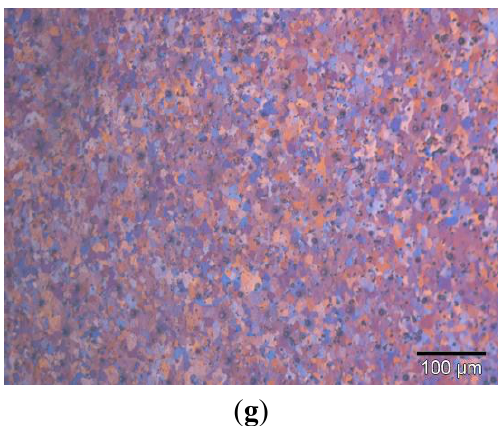
( g ) Figure 5. Optical micrographs for the N2 state material after the flash treatment (tr): ( a ) N0; ( b ) N2; ( c ) N2 + flash tr. = 240 °C; ( d ) N2 + flash tr. = 260 °C; ( e ) N2 + flash tr. = 280 °C; ( f ) N2 + flash tr. = 300 °C; ( g ) N2 + flash tr. = 320 °C.